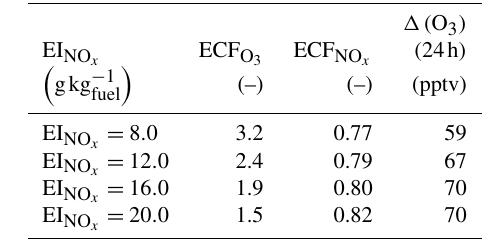
Table 5. Influence of NO x emission index on emission conversion factors and in-plume ozone perturbation